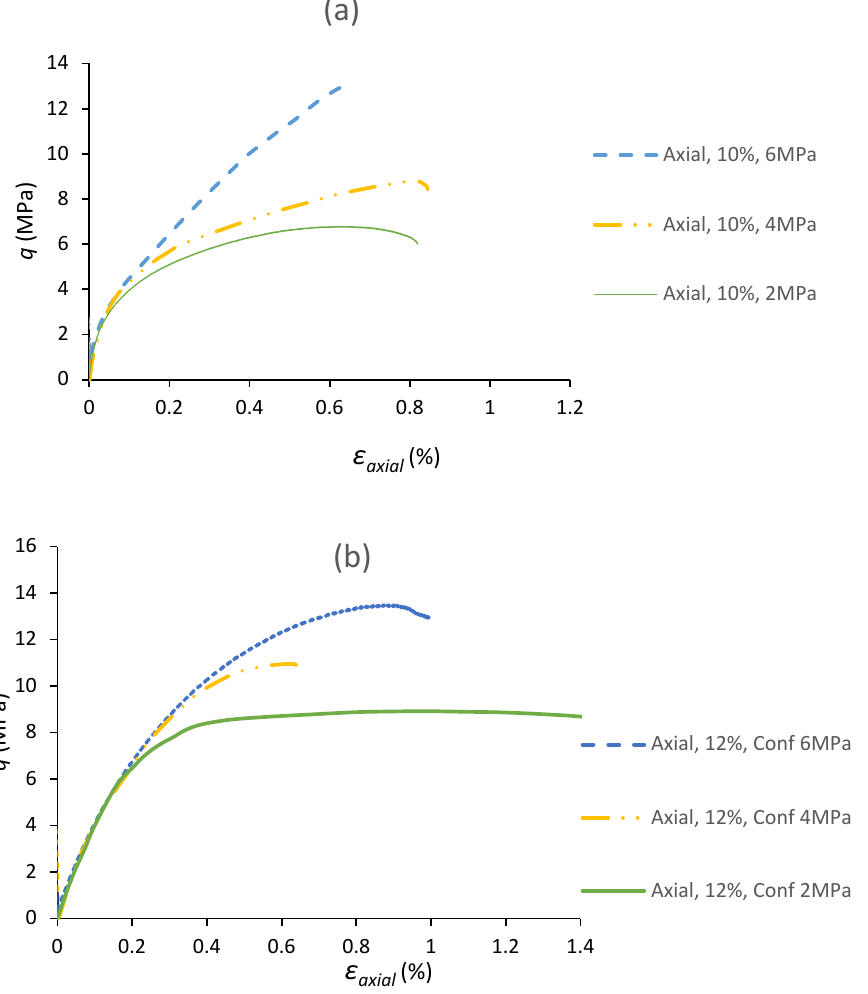
Figure 6. Deviatoric stress versus axial strain behaviour of solid specimens subjected to triaxial testing, ( a ) 10% cement content, ( b ) 12% cement content, ( c ) 14% cement content.